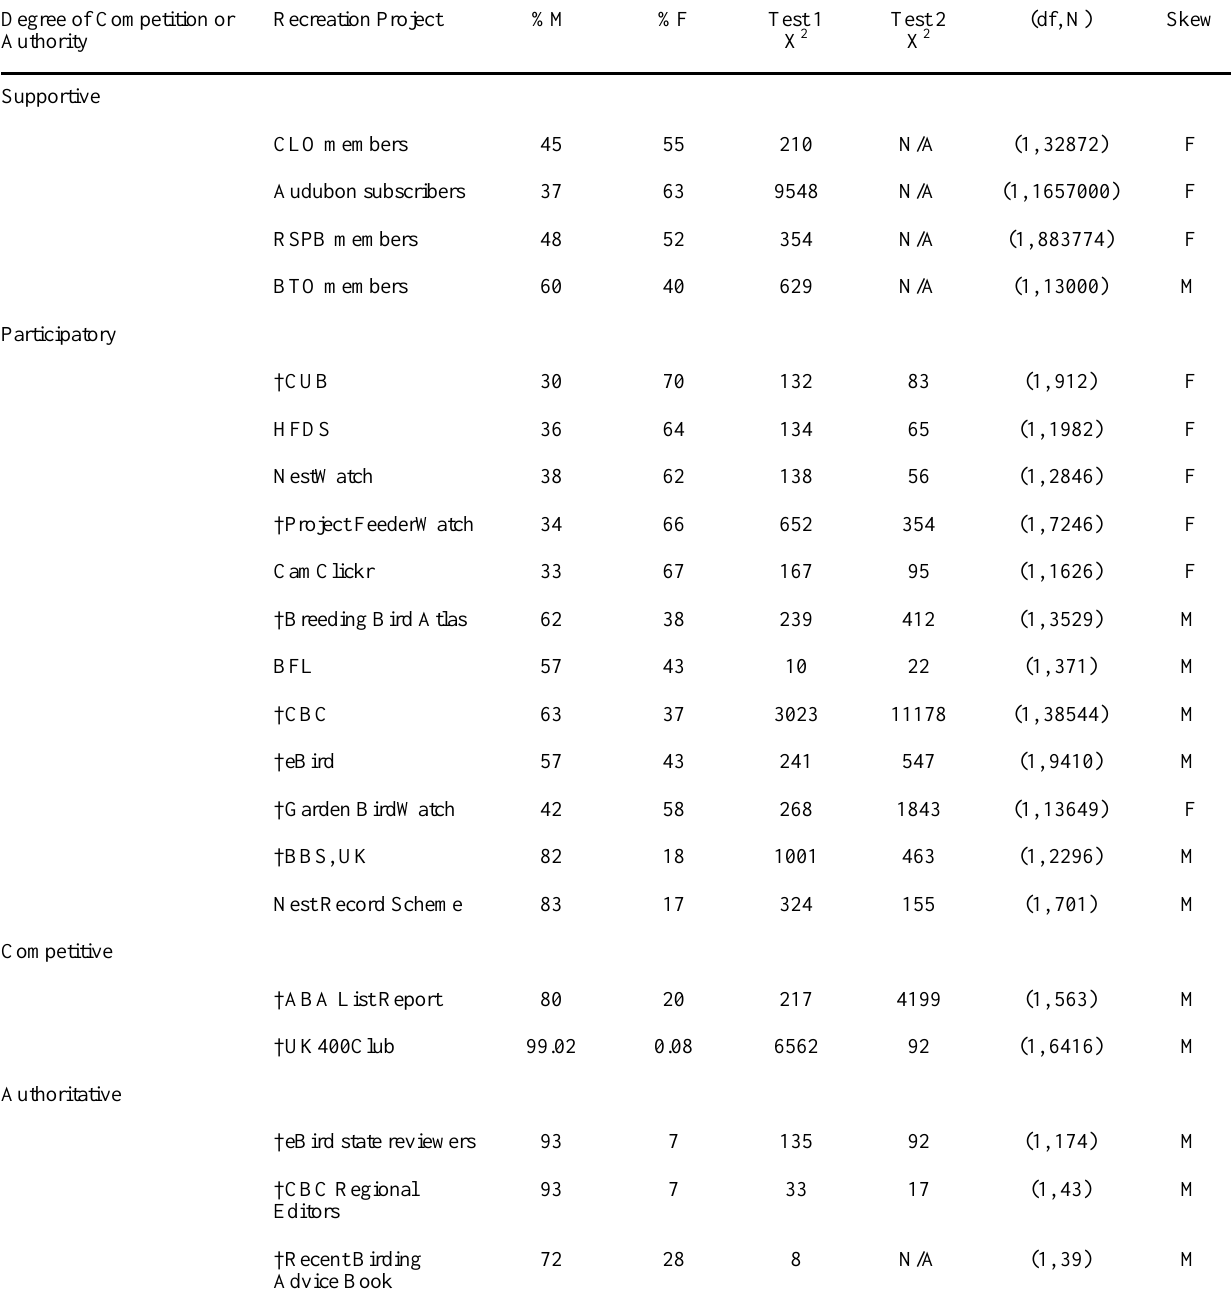
Table 3. The percentage of males and females based on data sources of different bird-based recreation projects in the UK and USA. The chi-square statistics computed for each data source were greater than the critical value, P( c 2 ‡ 3.841) = 0.05. Test 1 and Test 2 differ in the population used to compute the expected value, with Test 1 using the 49M:51F ratio of the general population and Test 2 using the gender ratio specific to the recreation project that is likely the source population for a particular project. † indicate recreation projects that involve listing. N is the number of individuals in each recreation project for which gender was known or